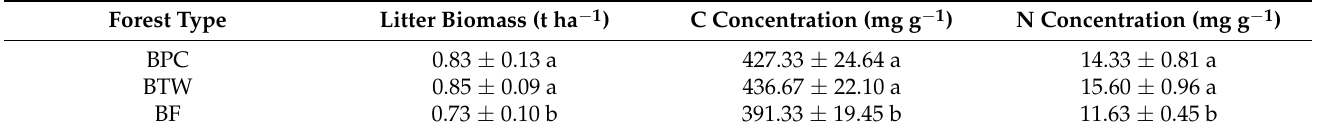
Lowercase letters in the same column indicate the differences between different forest types. BF, BPC, and BTW represent pure moso bamboo forest, bamboo forest interplanted with Phoebe chekiangensis , and bamboo forest interplanted with Taxus wallichiana var. maireii,